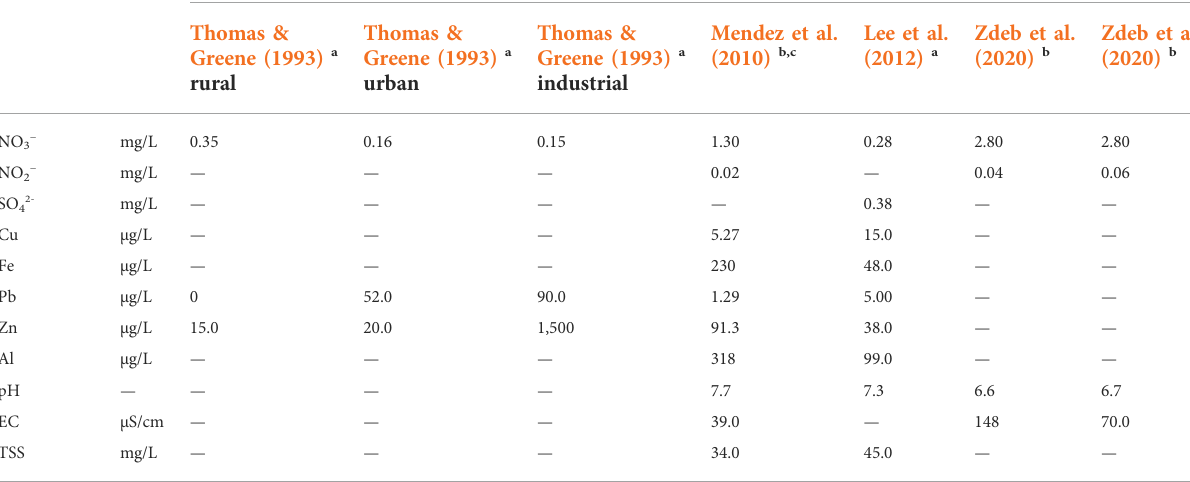
TABLE 3 Values of different parameters in concrete tile roof runoff after the fi rst fl ush.